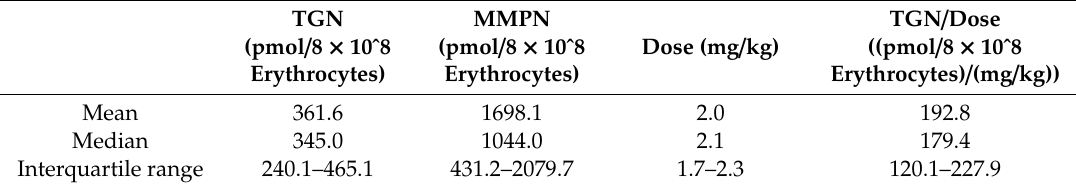
Table 3. Summary of azathioprine’s dose and metabolites’